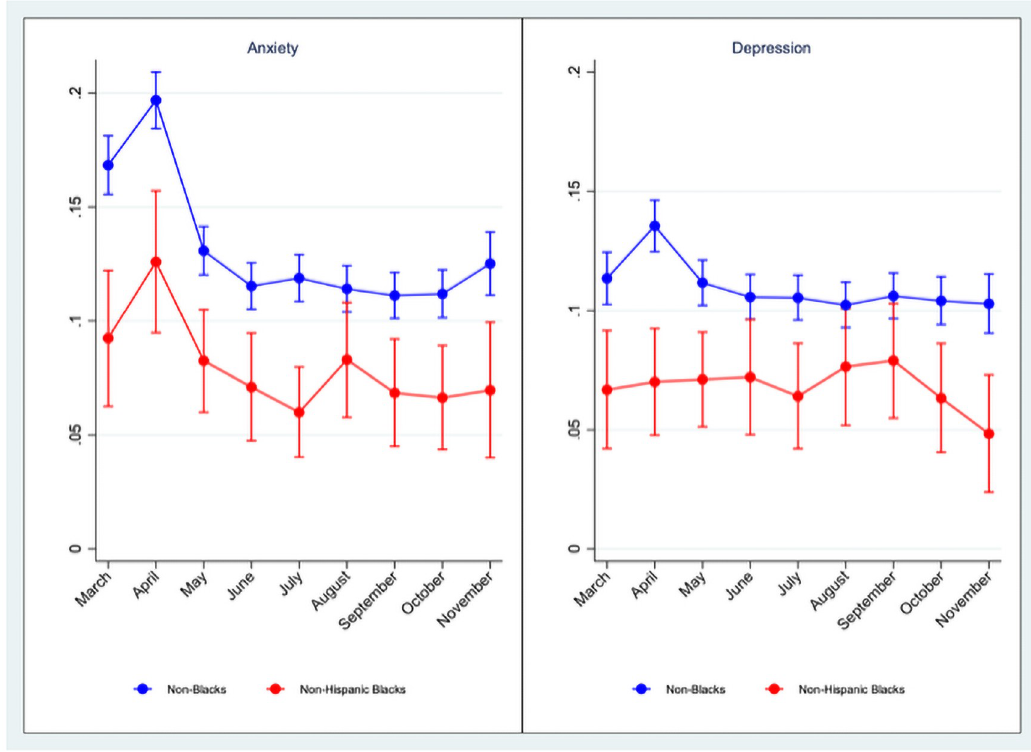
Fig 1. Predicted probabilities of reporting symptoms for anxiety and depression by